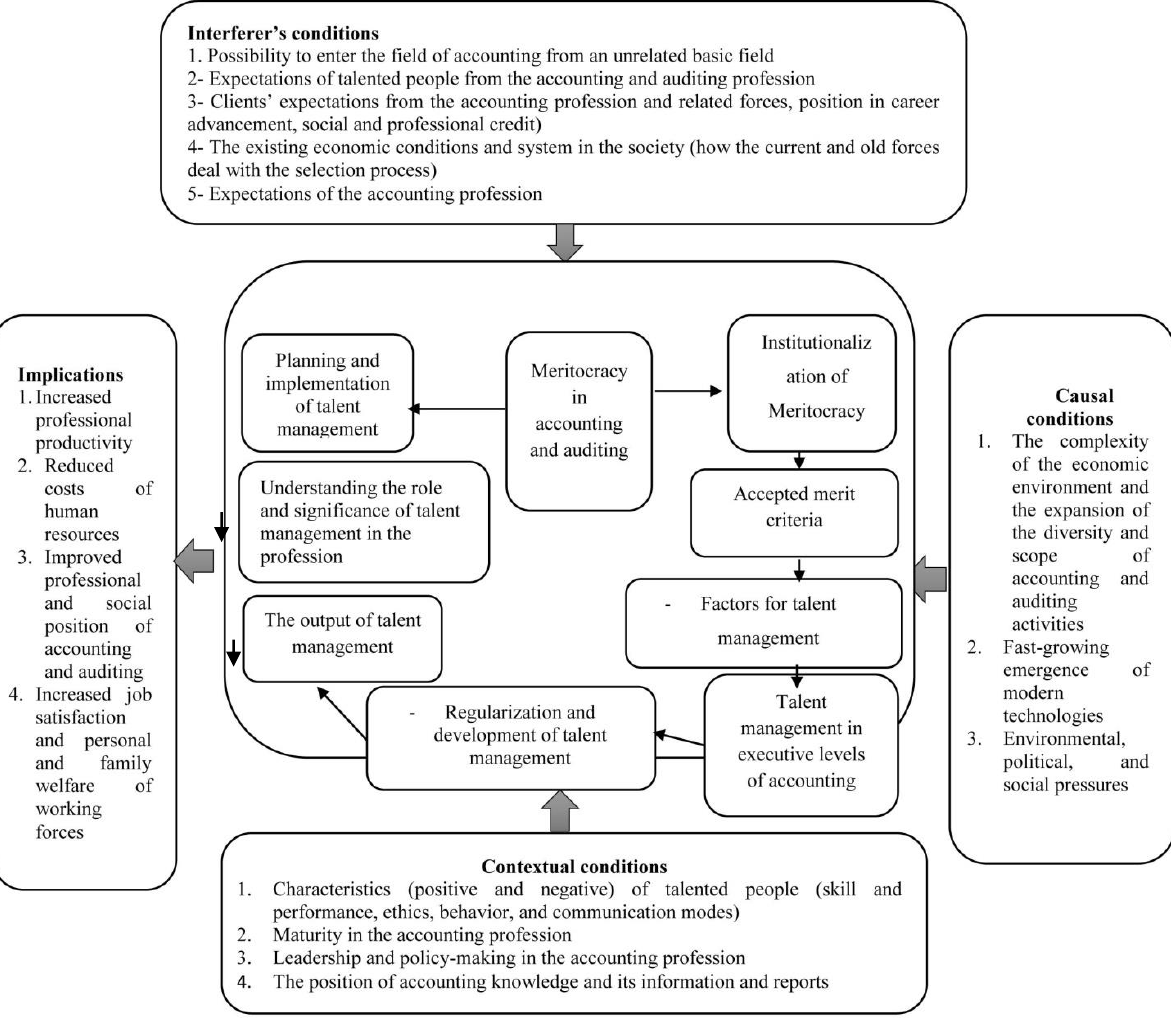
Figure 1. The proposed comprehensive research model for talent management in accounting and